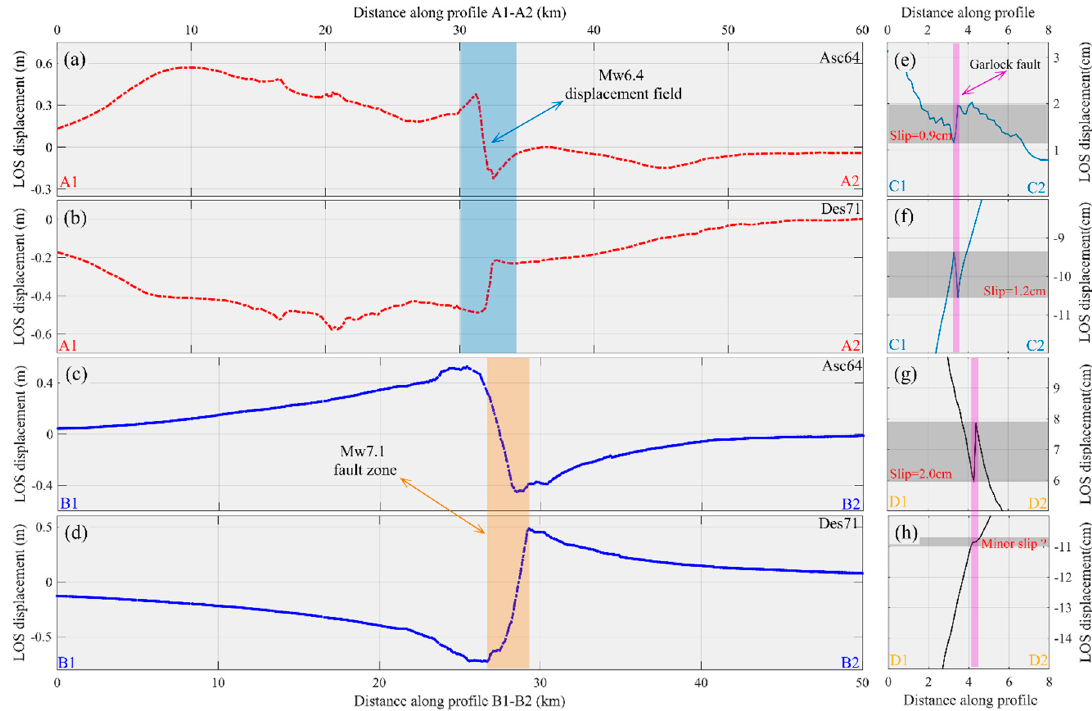
Figure 5. Profiles of the Ridgecrest earthquake sequence. The line-of-sight (LOS) displacement profile of ( a ) the ascending deformation field and ( b ) the descending deformation field along A1-A2; The LOS displacement profile of ( c ) the ascending deformation field and ( d ) the descending deformation field along B1-B2; ( e – h ) jointly reveal the triggered creep on the Garlock fault perpendicular to profiles C1-C2 and D1-D2.